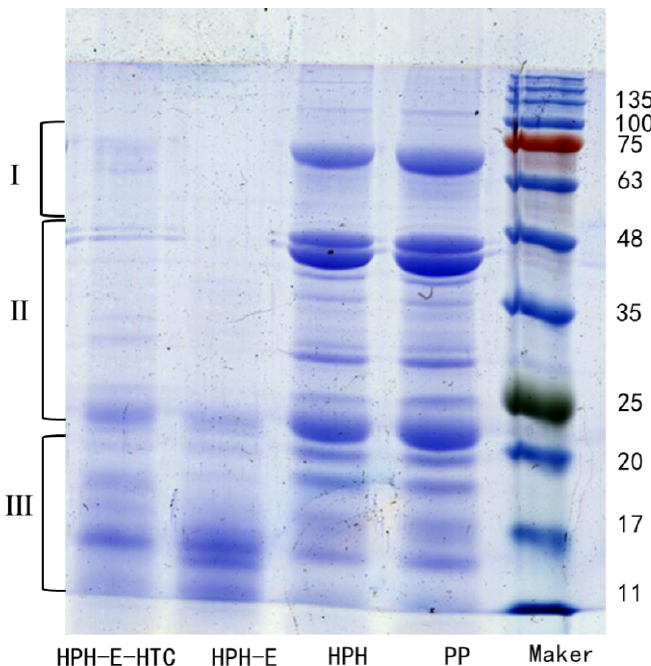
Figure 3. Sodium dodecyl sulphate–polyacrylamide gel electrophoresis profiles of peanut protein (PP), high pressure homogenized protein (HPH), high pressure homogenized and enzyme treated protein (HPH-E), and HPH-E-hydrothermally cooked (HPH-E-HTC) protein. Further treatment of HPH treated protein with enzyme did not show aggregated protein bands, and bands II and II also disappeared due to enzymatic digestion. Interestingly, enzyme treatment of HPH treated peanut increased the intensity of band III, suggesting digestion (breakdown) of high molecular weight fractions into smaller ones followed by their aggregation [21]. Further treatment of HPH-E with heat treatment, i.e., HPH-E-HTC, further reduced the intensity of low molecular weight protein fractions